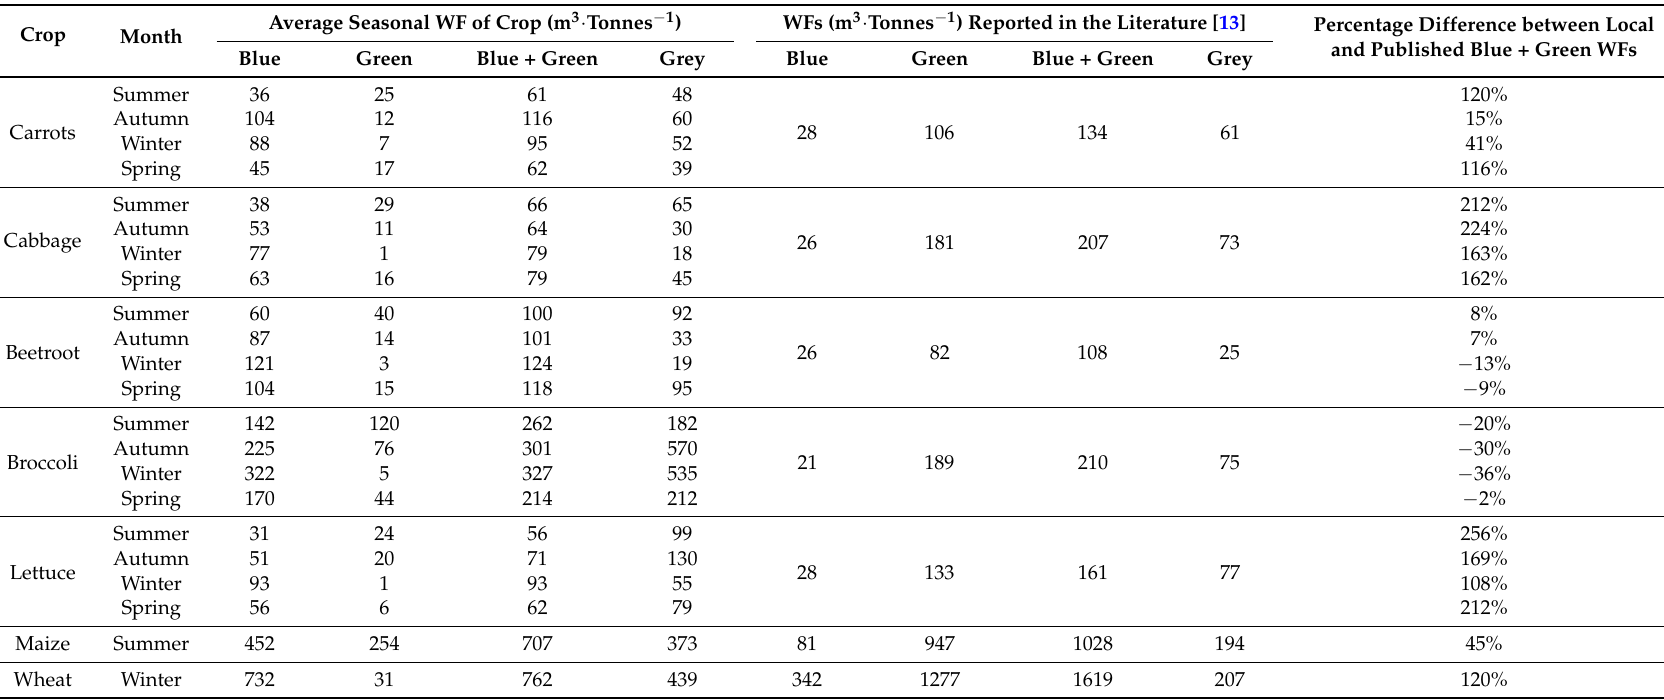
Table 5. Blue, green and grey water footprints using fresh mass as a functional unit for cultivating vegetable crops, maize and wheat on the Steenkoppies Aquifer compared to outcomes from the